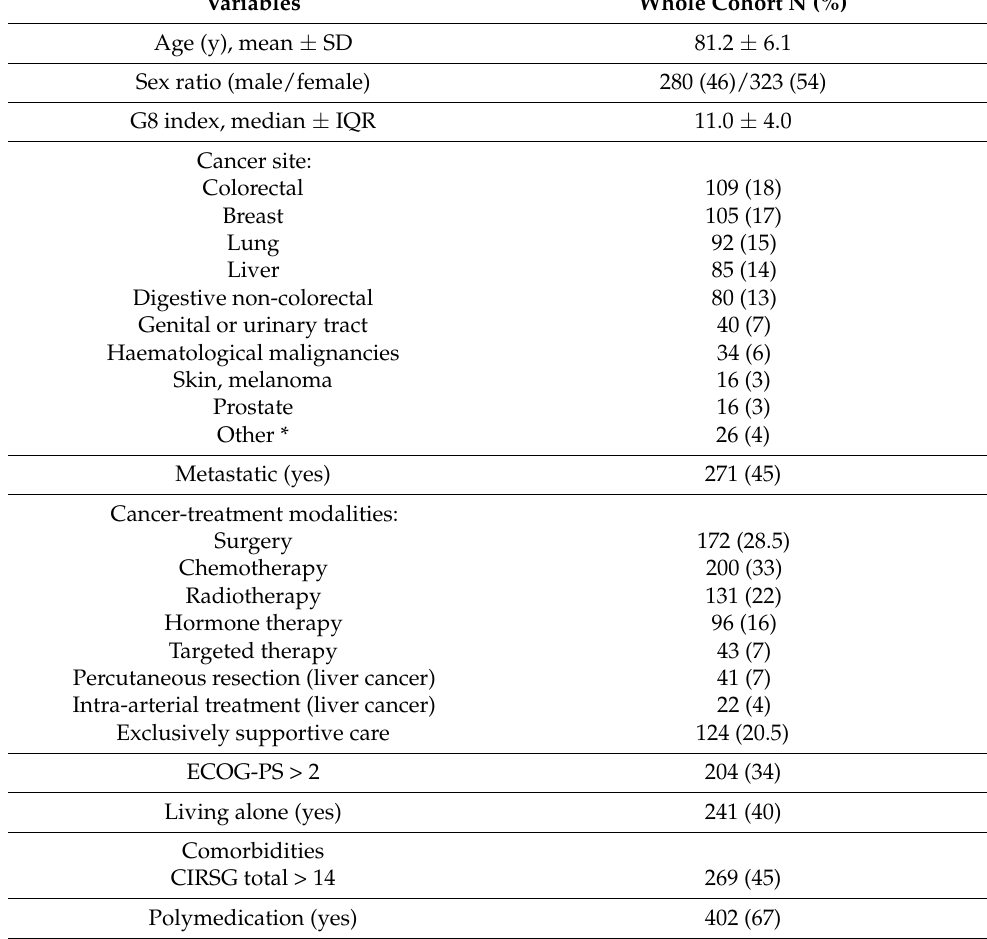
Table 1. Baseline characteristics of the 603 older outpatients with cancer in the PF-EC cohort.